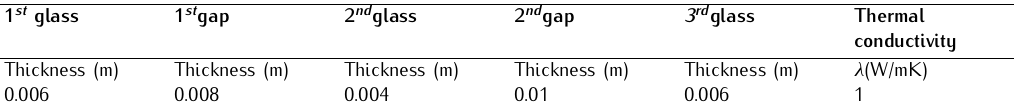
Table 1. Characteristics of the triple glazing studied.